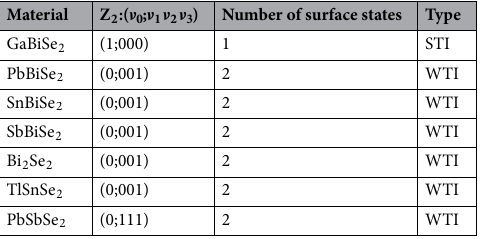
Table 3. Calculated Z 2 invariants for different